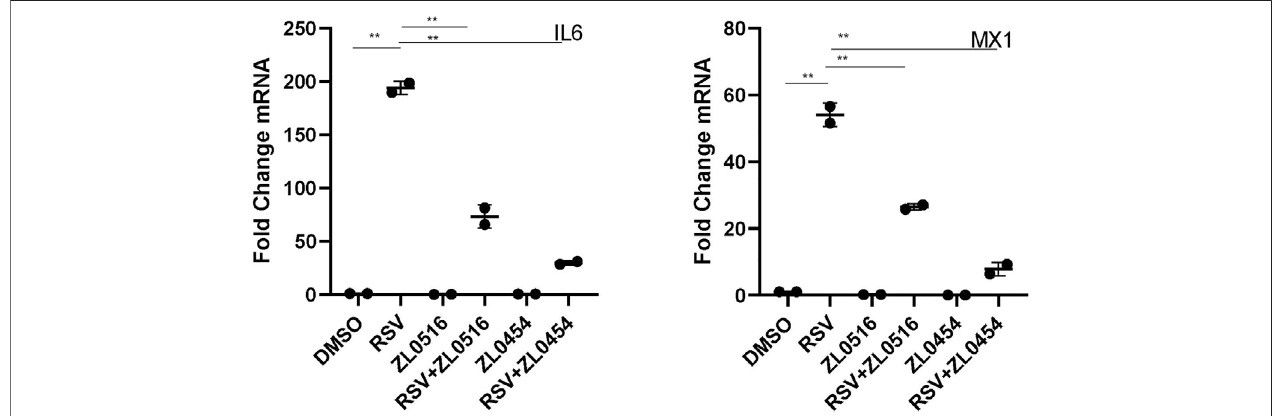
FIGURE 1 | Effect of BRD4-selective small-molecule inhibitors on RSV-induced cytokines. qRT-PCR was performed in HSAECs treated in the absence or presence of 10 μ M concentrations of indicated BRD4 inhibitors. HSAECs were infected with puri fi ed RSV (MOI (cid:1) 1) for 24 h. Fold change mRNA relative to PPIA is plotted for IL-6 (left) and MX1 (right) . p < 0.01 in ANOVA across treatment groups; ** and p < 0.01 in pairwise